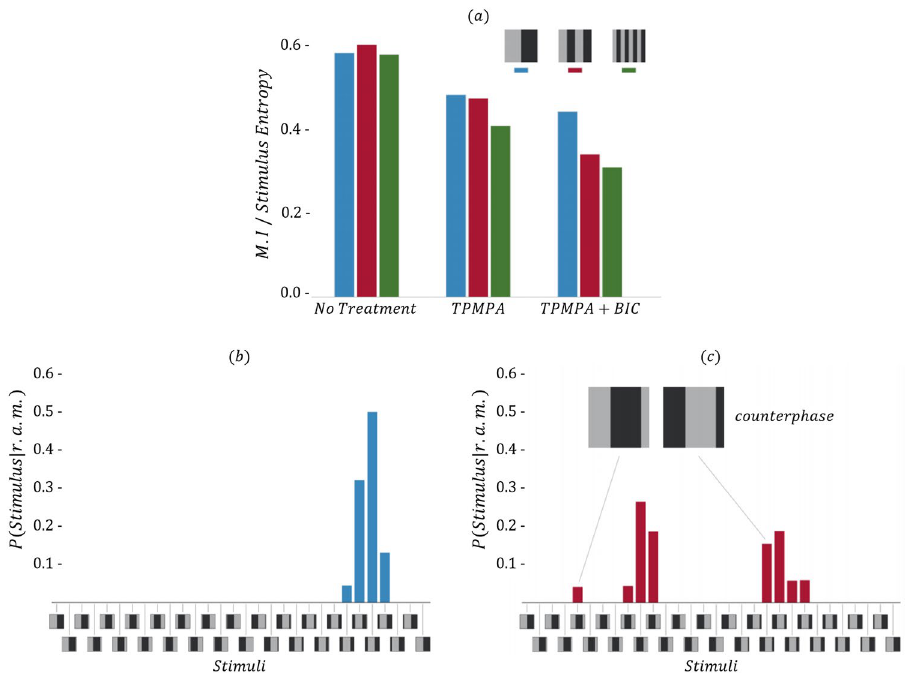
Figure 3. Results related to Experiment 2. Panel ( a ) shows the mutual information associated with (left to right) retina without GABA blockage, retina with GABA C blockage and retina with also GABA A and GABA B blockage. Different colors are associated with gratings with different spatial frequency: 0.011, 0.023 and 0.045 cycles/ degree in blue, red and green, respectively. Panels ( b , c ) show the distribution of the stimuli associated with a single latent state. While in retina without impairment a good match is found ( b ), blocking GABA receptors results in a mismatch ( c ): stimuli in counterphase are encoded in the same